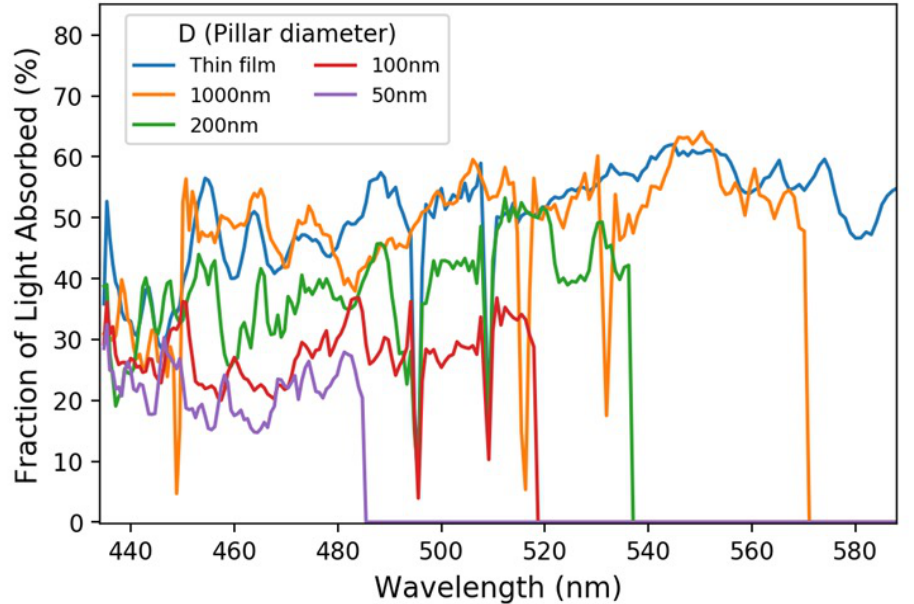
Figure 4. Broadband characteristics of the absorption responses of various photodetectors with different nanopillar diameters. The fraction of light absorbed in percentage as a function of the wavelength for each photodetector is shown. The structure of the photodetector is given in Figure 1. The absorption cut-off wavelengths are 485 nm, 518 nm, 536 nm, 570 nm, and 590 nm in the order of the nanopillar diameter starting from 50 nm. The incident light is unpolarized and has a 0 ◦ incident angle, i.e., normal to the detector